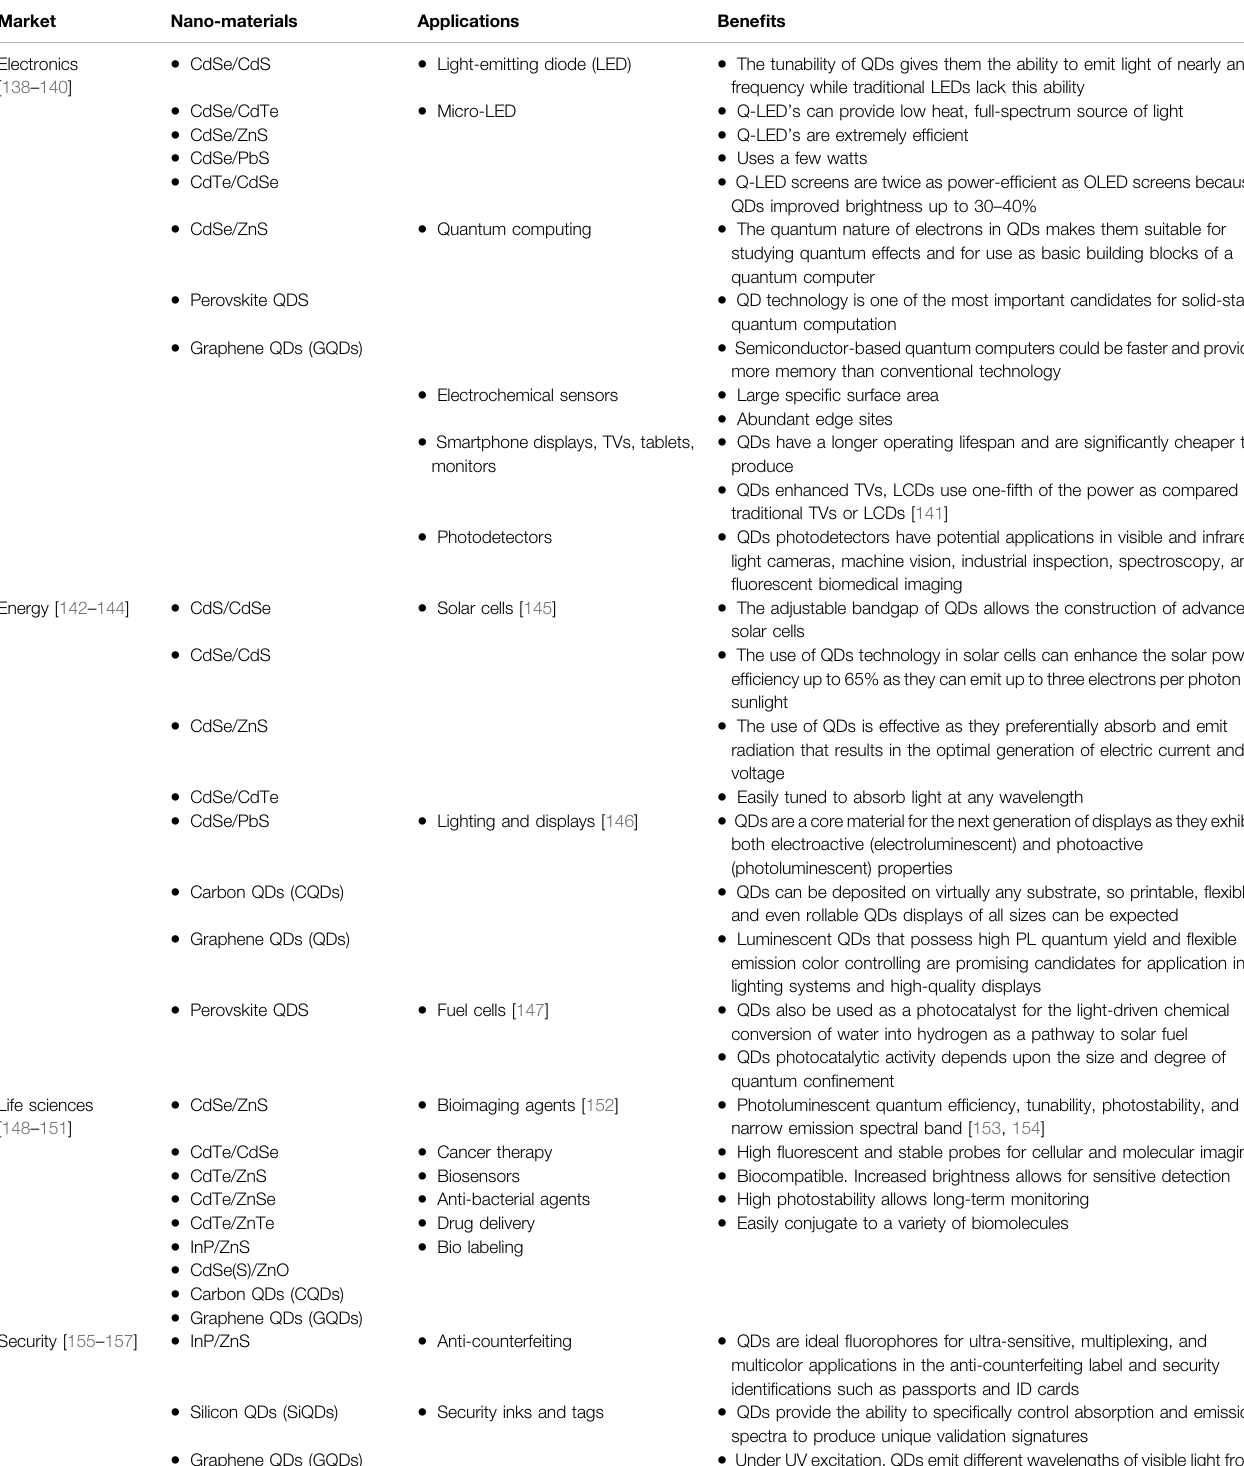
TABLE 3 | Various applications of quantum dots (QDs) in different fi elds.